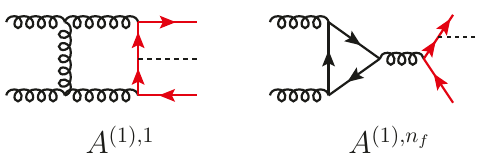
Figure 1. Sample Feynman diagrams corresponding to the various closed fermion loop contribu- tions at one loop as specified in eq. (2.8). Black-dashed, red, black-spiralled and black lines represent Higgs bosons, bottom quarks, gluons and light quarks (bottom quarks included), respectively.